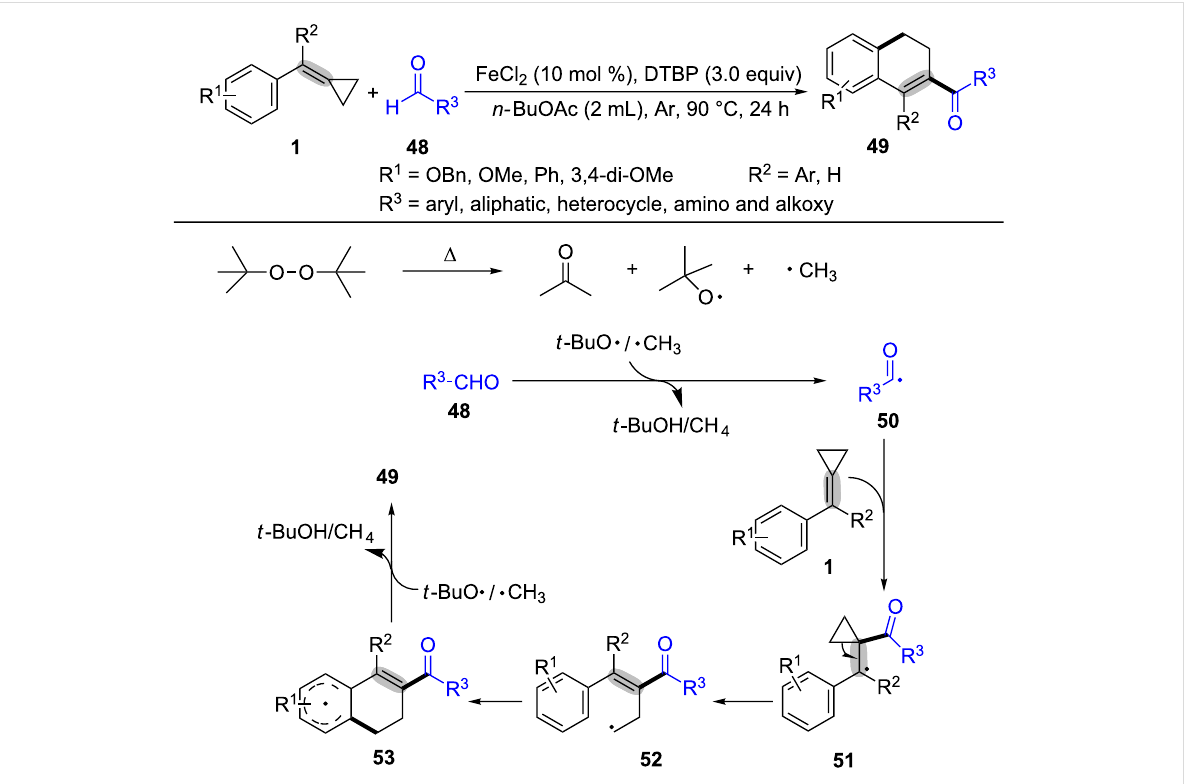
Scheme 12: Oxidative radical ring-opening and cyclization of MCPs with aldehydes.